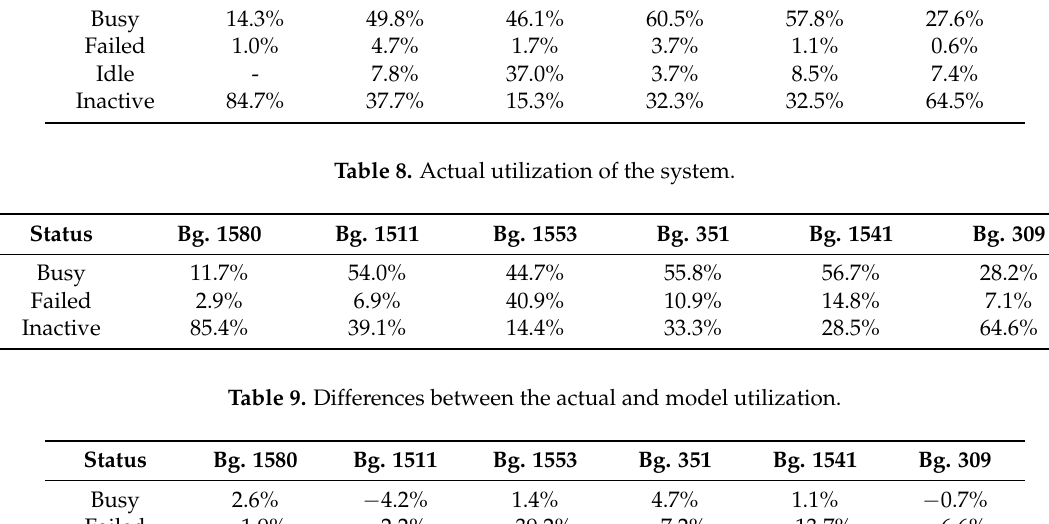
Experiment 3: Simulation Model with Stochastic Component “Breakdown Behavior” and “Reserve